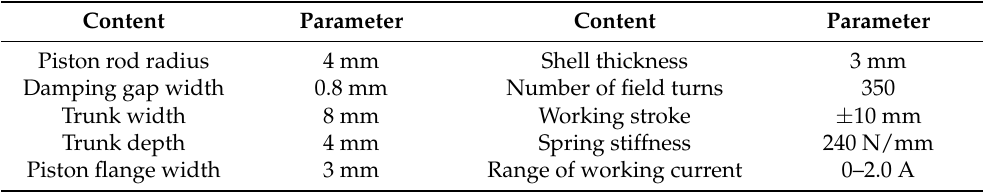
Table 1. Main design parameters of the MR damping clamp.